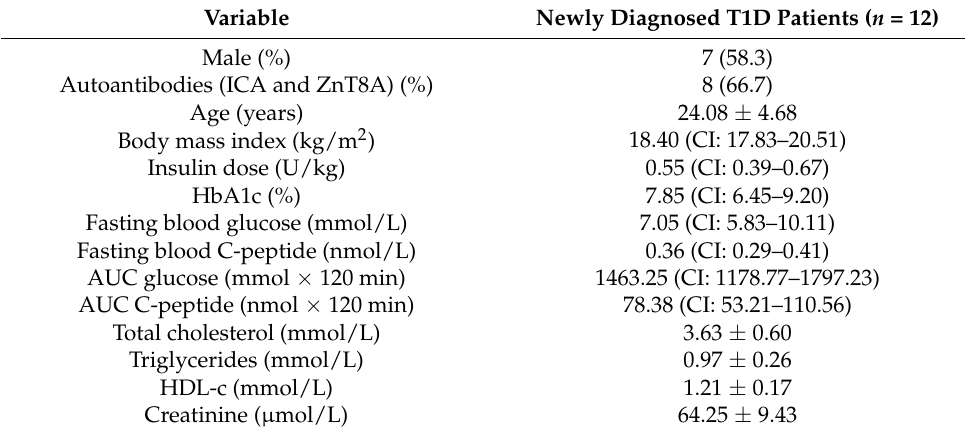
Table 1. Baseline characteristics of the study population.